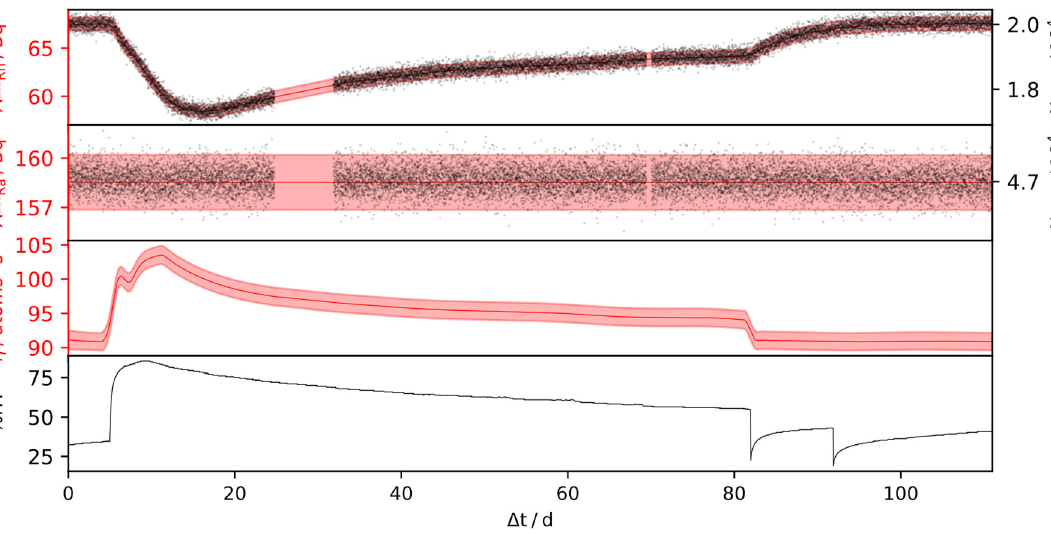
Figure 8. SLDS-deconvolution result for an IRSD of approx. 65 Bq 226 Ra. Black dots represent the determined peak areas of a set of approx. 9000 spectra, taken over 65 days at a sampling interval of 600 s of 222 Rn and 226 Ra, respectively. Red curves represent the smoothed results for the residual 222 Rn- and 226 Ra activities and the deconvolved time-series of the emanation (cid:2015) , according to Section 2.5. Shaded areas represent the 1 (cid:2026) credible intervals, almost entirely caused by the systematic uncertainty. From the presented deconvolution results in Figures 7 and 8, it is evident that the relative humidity impacts the emanation positively. Therein, changes of the steady-state